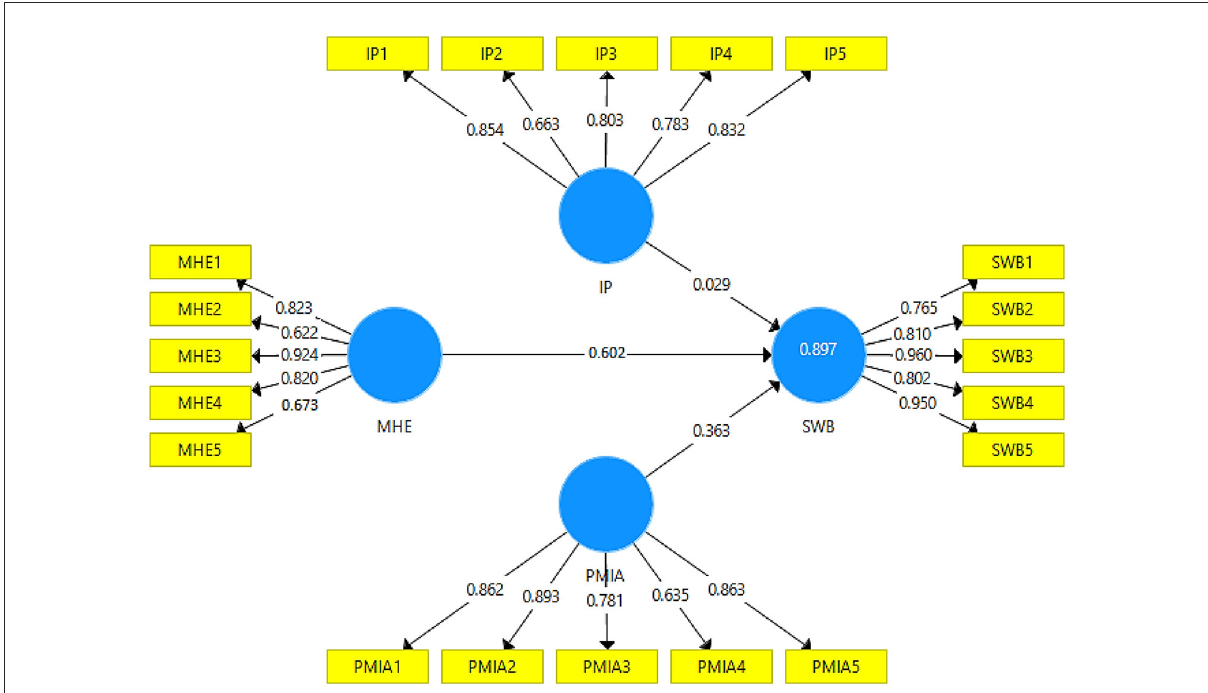
FIGURE2 Measurement model. MHE, Mental Health Education; IP, Ideological Passion; SWB, College Student’s Wellbeing; PMIA, Politically Motivated Internet Addiction.